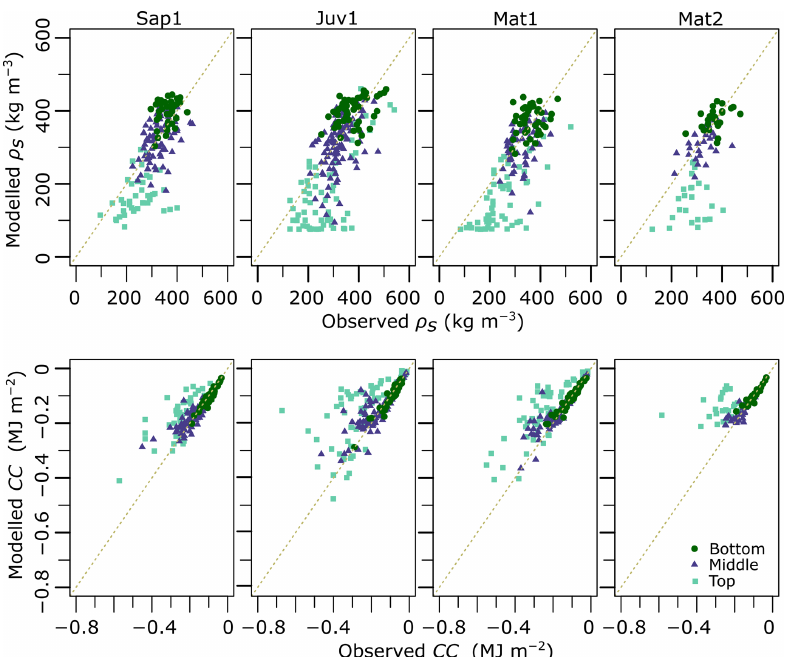
Figure 7. Observed versus modelled snow density and CC derived from the empirical formulation described in Sect. 2.2.3 across the four sites. Snowpack layers are aggregated into three classes: top (upper 40cm), bottom (lower 30cm), and middle (remainder).